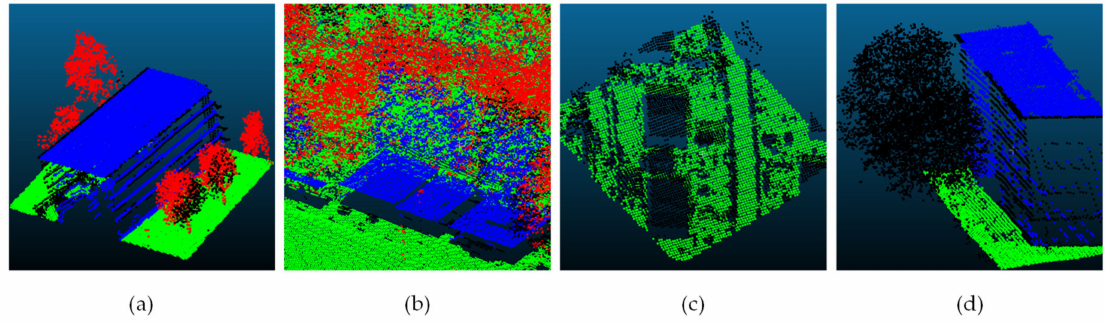
Figure 2. ( a ) Ground truth result; ( b ) Corresponding point-in-polygon result. Building, navy blue; tree, red; water, brown; terrain, green; bridge, cyan; and unlabeled, black.